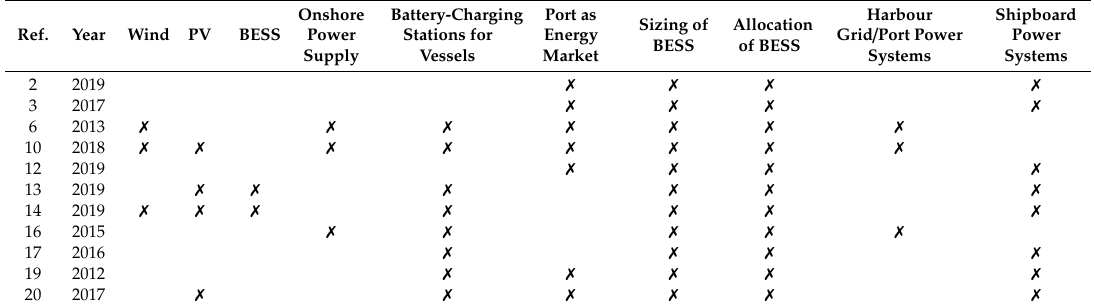
Table 1. Taxonomy of literature review. PV: photovoltaic; BESS: battery energy storage